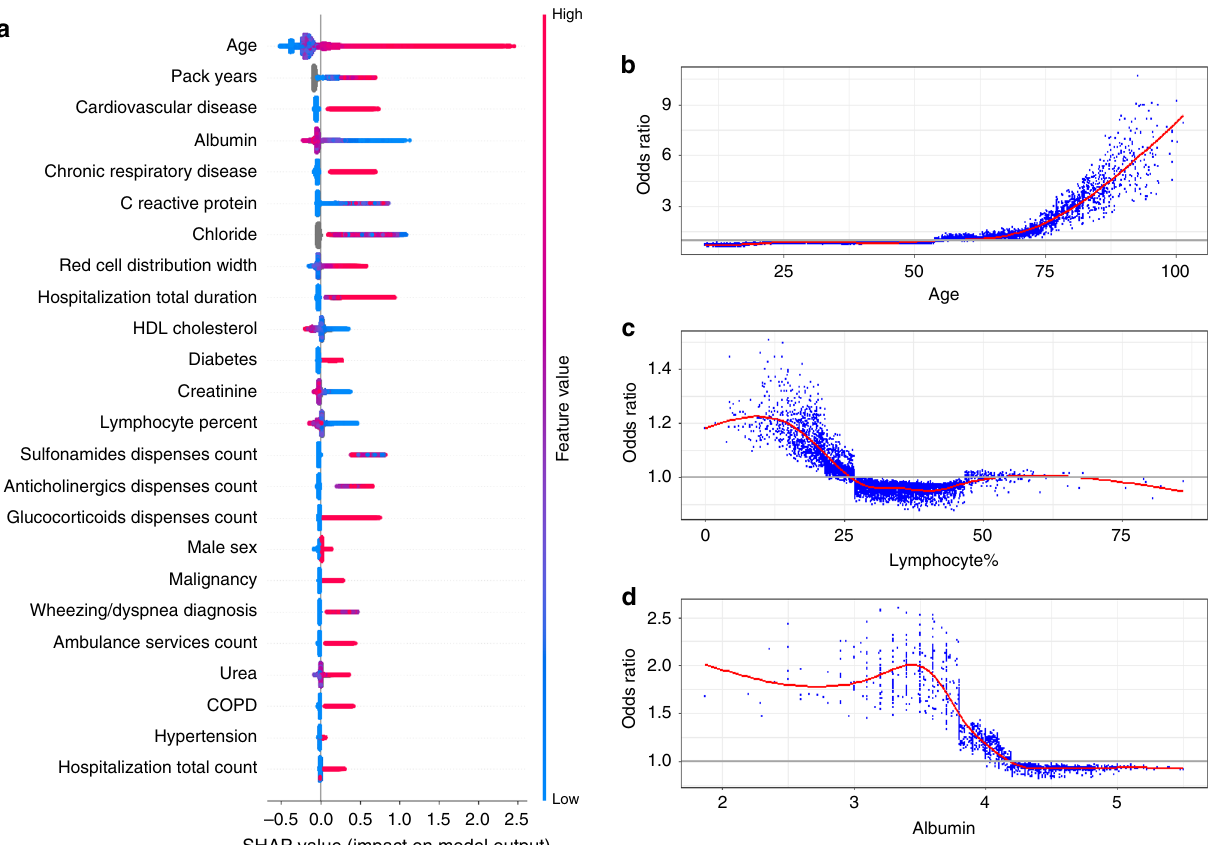
Fig. 1 Summary and feature-speci fi c SHAP values for the baseline model. a A summary plot of the SHAP values for each feature. Going from top to bottom, features are ordered by their overall importance in creating the fi nal prediction (sum of SHAP values). In each feature (line), every point is a speci fi c case (individual), with colors ranging from red (high values of the predictor) to blue (low values of the predictor). Gray points signal missing values. The point ’ s location on the X -axis represents the SHAP value — the effect the variable had on the prediction in this speci fi c individual, with points further to the right marking that for that individual this covariate contributed to increasing of the risk and points to the left indicate that the covariate contributed to decreasing the risk. The vertical line in the middle represents no change in risk. b A plot of the odds ratio for different values of age. A smoothed red line is fi t to the curve and a horizontal gray line is drawn at odds ratio = 1. c A plot of the odds ratio for different values of percent of lymphocytes in the blood. A smoothed red line is fi t to the curve and a horizontal gray line is drawn at odds ratio = 1. d A plot of the odds ratio for different values of albumin. A smoothed red line is fi t to the curve and a horizontal gray line is drawn at odds ratio = 1. a is based on the training set of the baseline population, n = 625,500 unique patients. b – d use a random sample of patients from this same population, n = 10,000 unique patients. SHAP SHapley Additive exPlanations, HDL high-density lipoprotein, COPD chronic obstructive pulmonary